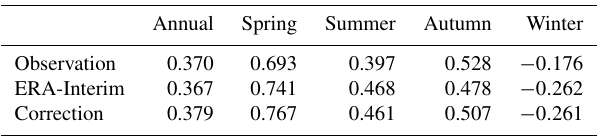
Table 8. Trends ( ◦ C10a − 1 ) of annual and seasonal T max over the 24 sites in 1979–2013.